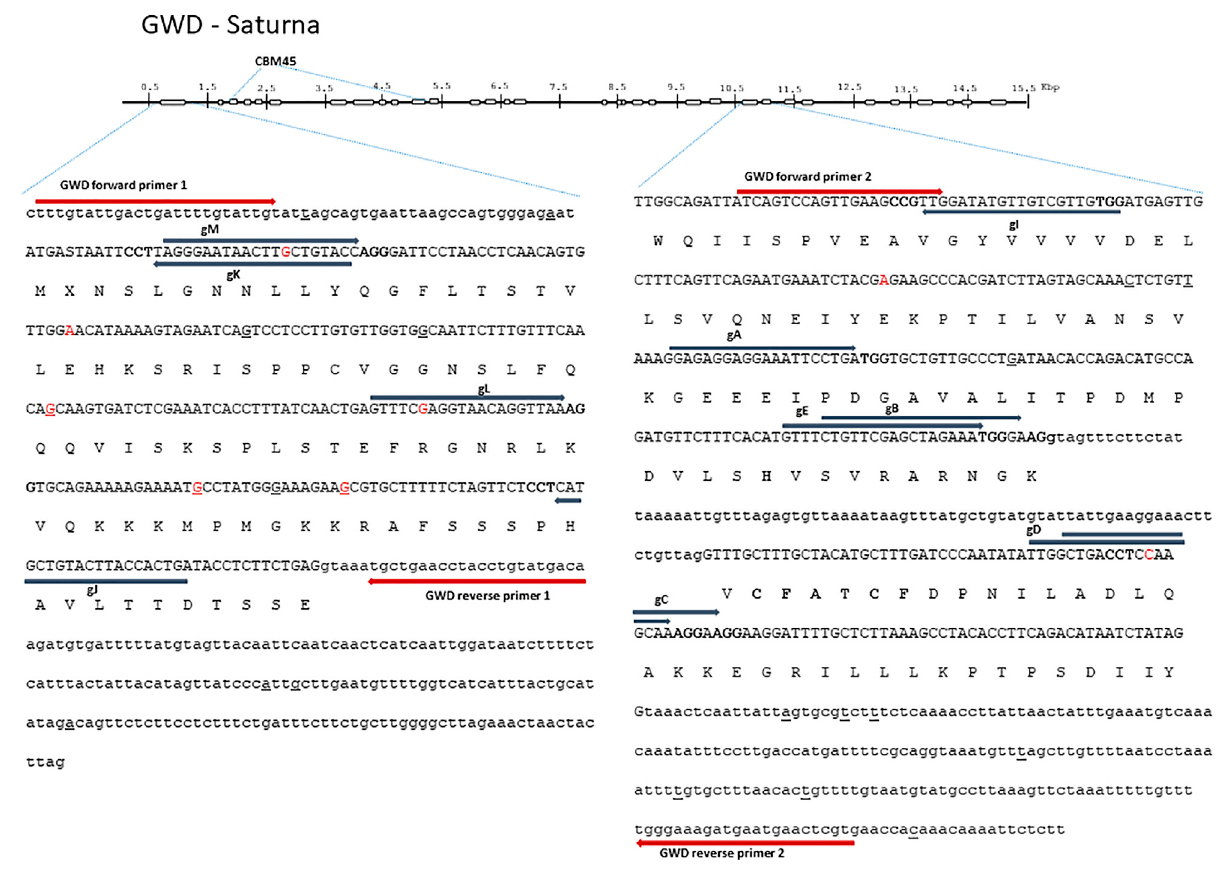
Frontiers in Genome Editing |